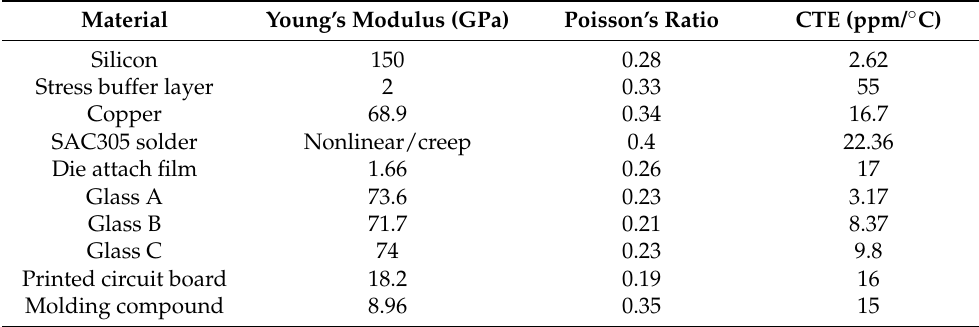
Table 2. Summary of the material properties of the components in the FO-WLP. CTE, coefficient of thermal